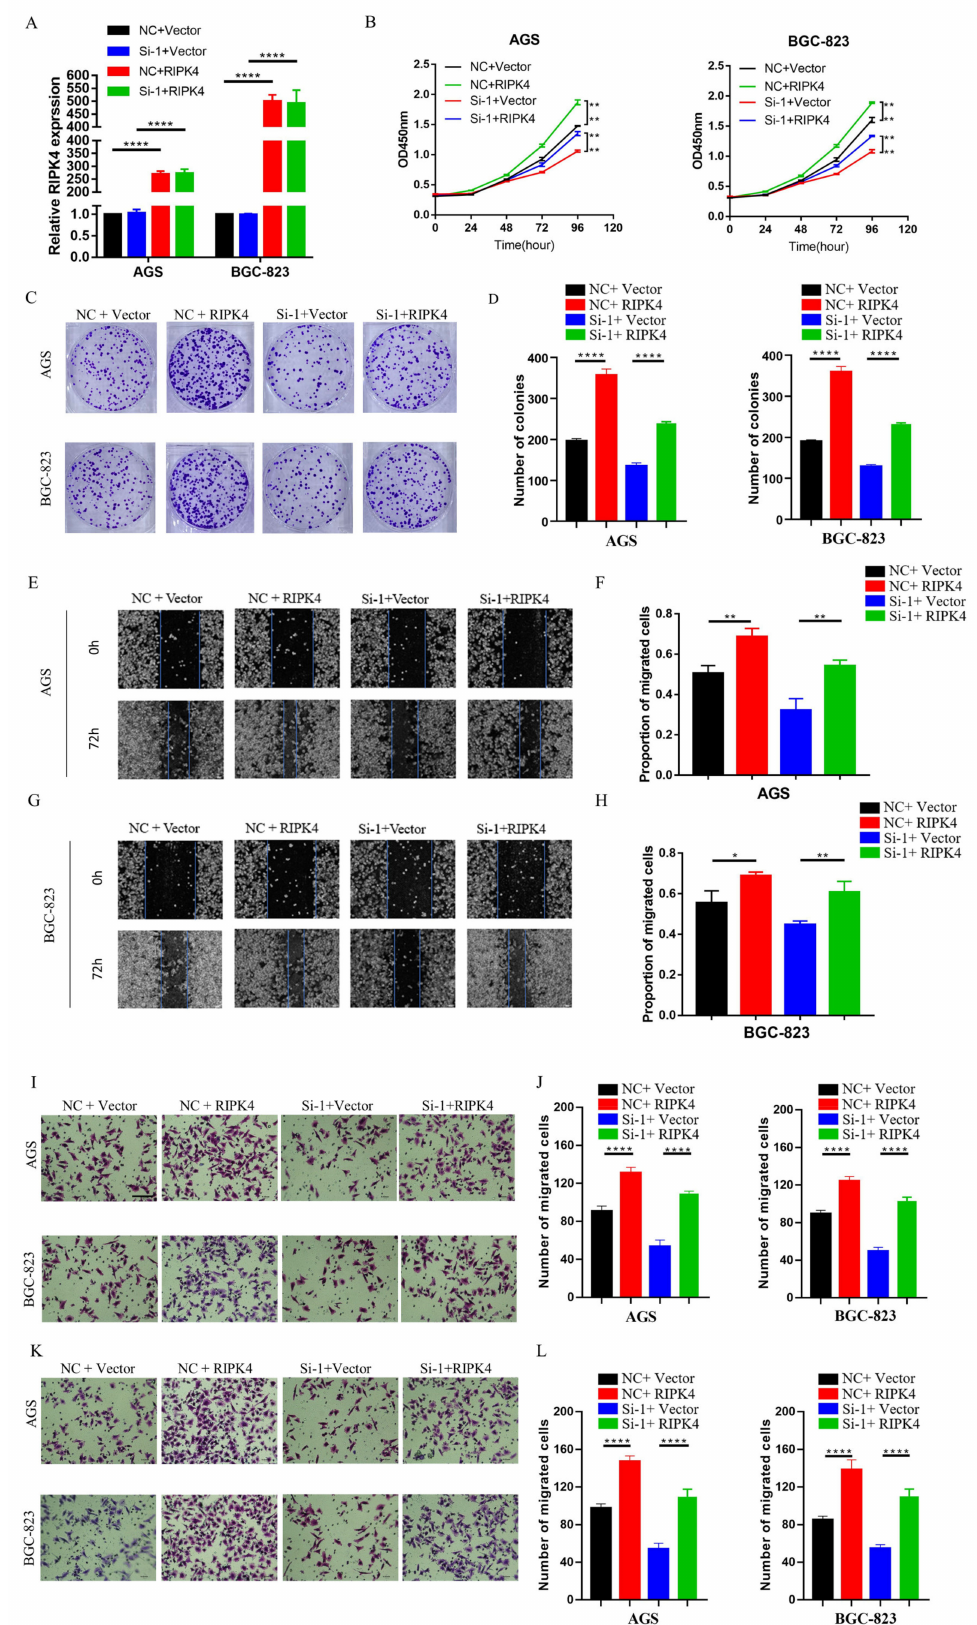
Figure 5. LINC01537 promotes proliferation, migration, and invasion of GC cells by activating the RIPK4-NF- κ B pathway. qRT-PCR ( A ) and Western blot ( B ) analysis of the levels of RIPK4 in si-NC